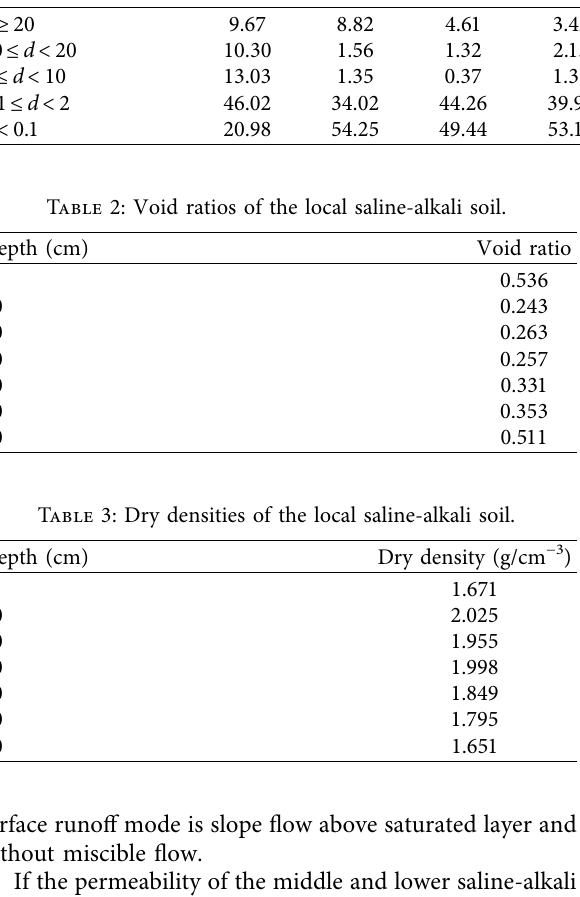
Table 1: Volume ratios of pores of the local saline-alkali soil (%). Depth of soil specimen (cm) Pore diameter ( μ m)